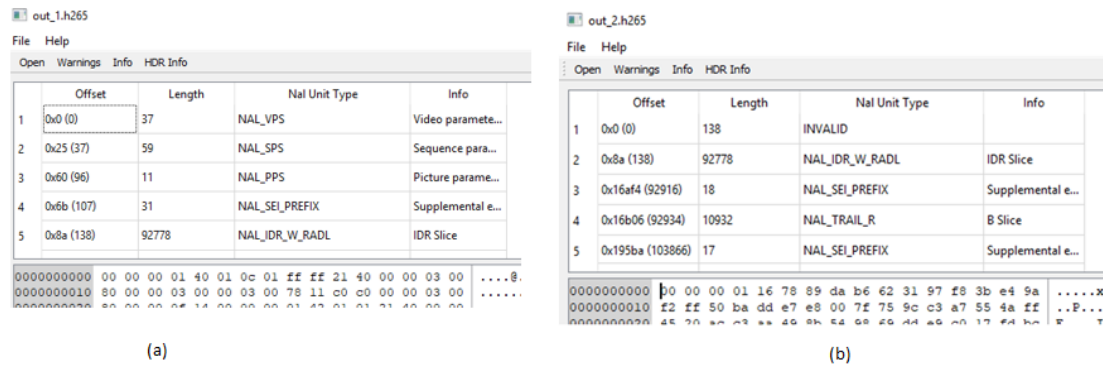
Figure 17. Hevcbrowser parsing: ( a ) unencrypted HEVC bitstream; ( b ) encrypted HEVC bitstream. Table 6. WS-PSNR (Peak Signal-to-Noise Ratio) comparison.